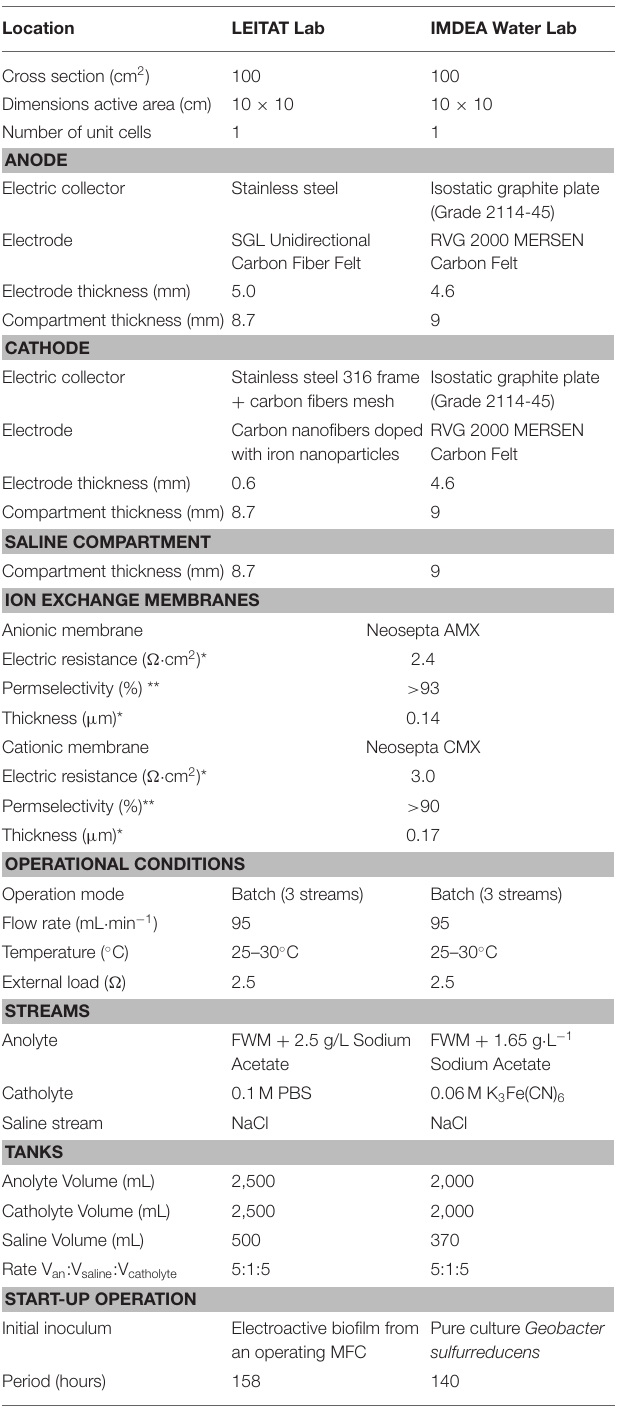
TABLE 1 | Main features for MDC experimental